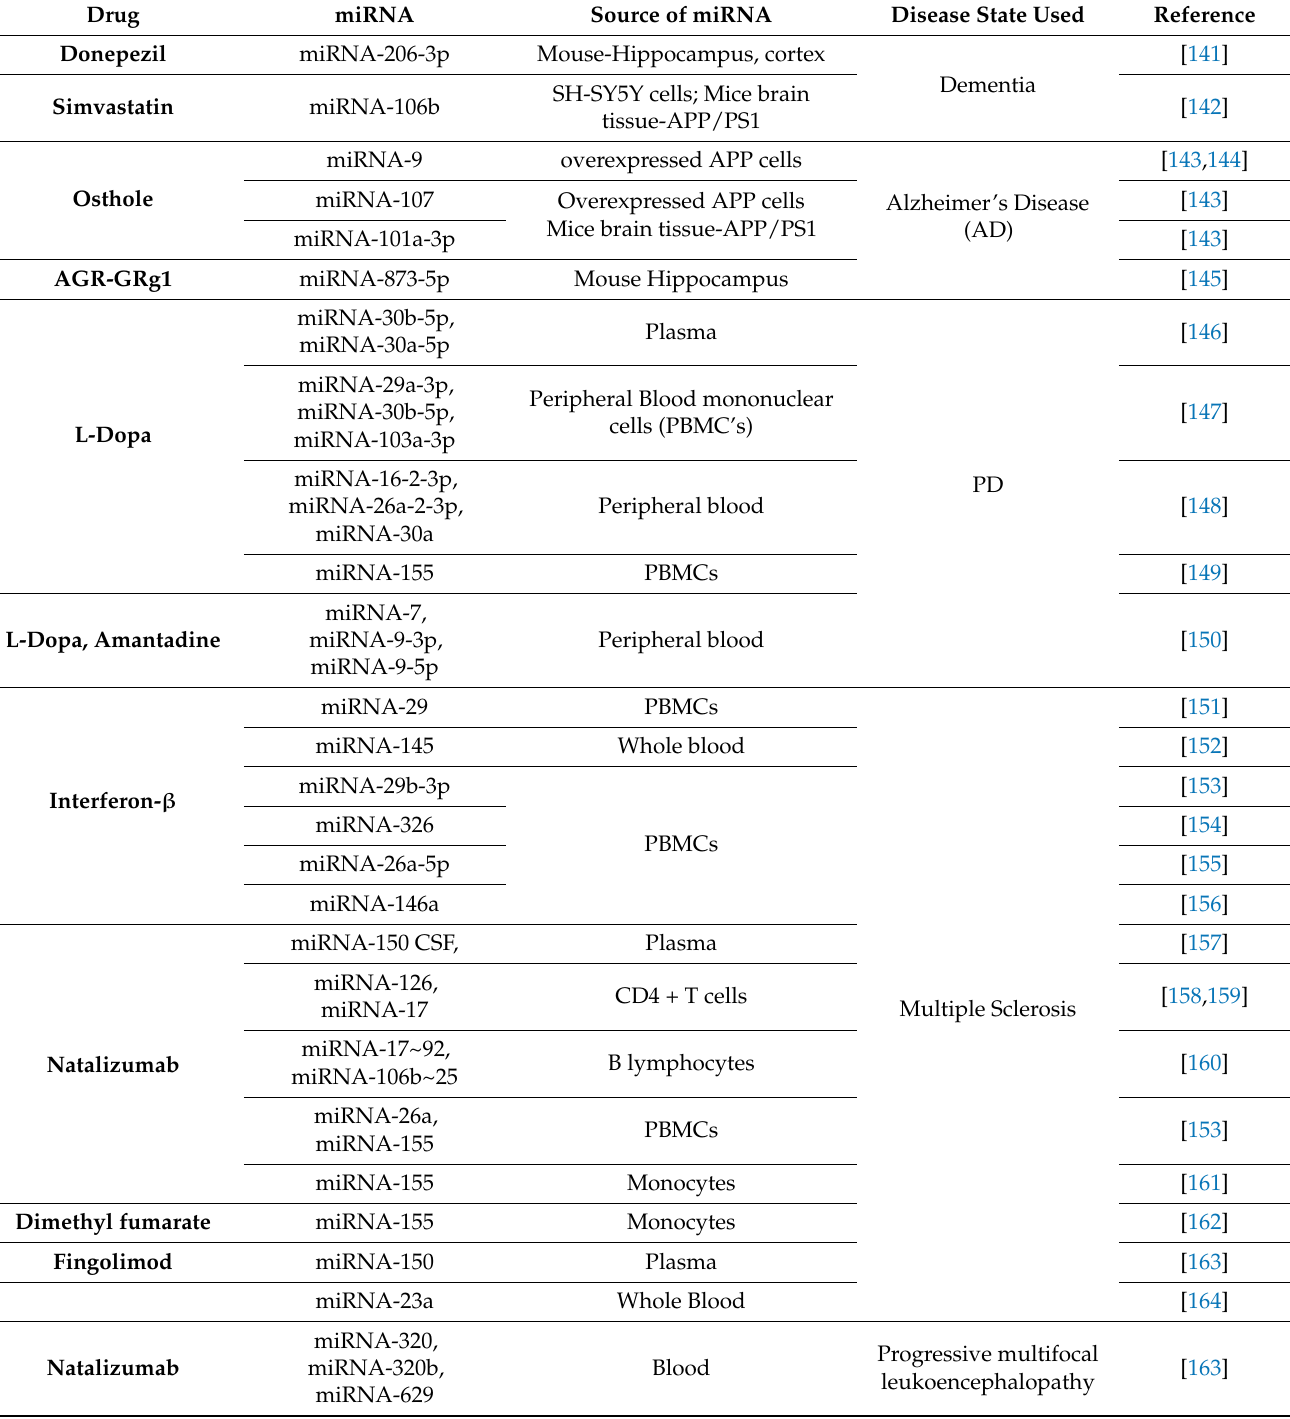
Table 3. List of miRNAs used as therapeutics (conventional and nonconventional) for some NDDs. The investigated drug, the miRNAs, their sources, the disease state as well as the references are